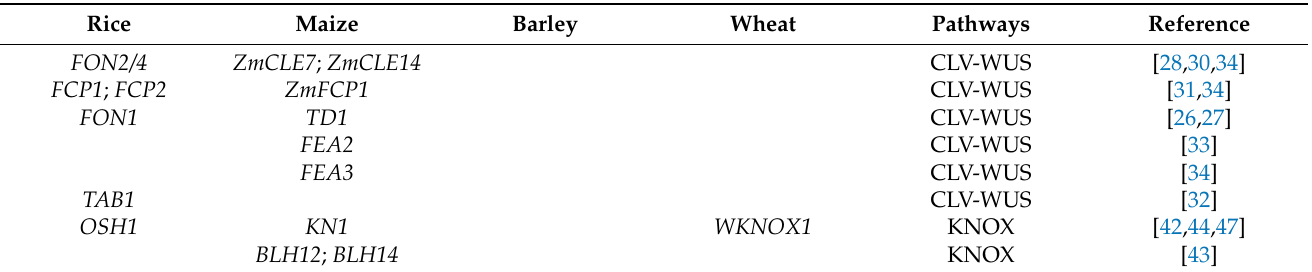
Table 1. Key regulators involved in the transition from SAM to IM in rice, maize, barley and wheat. Rice